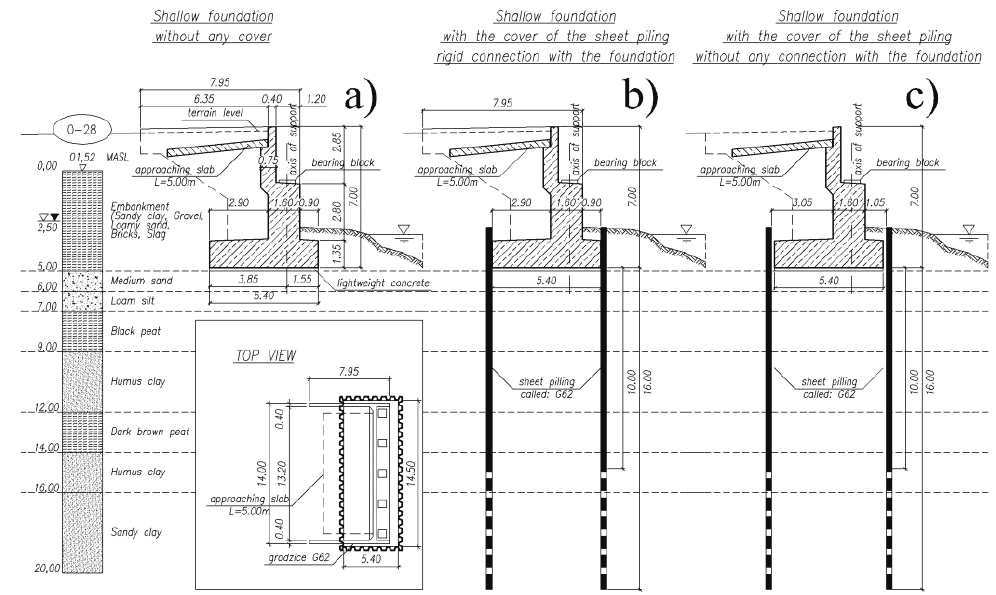
Fig. 2. Diagrams of relation between the foundation of the bridge abutment, and the cover made of sheet piling, adopted in the numerical calculations done by the